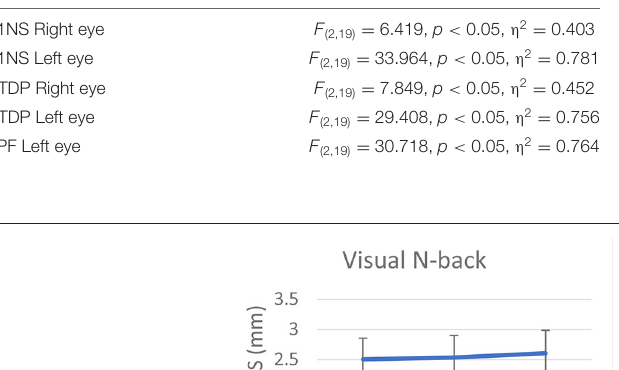
Frontiers in Psychology |